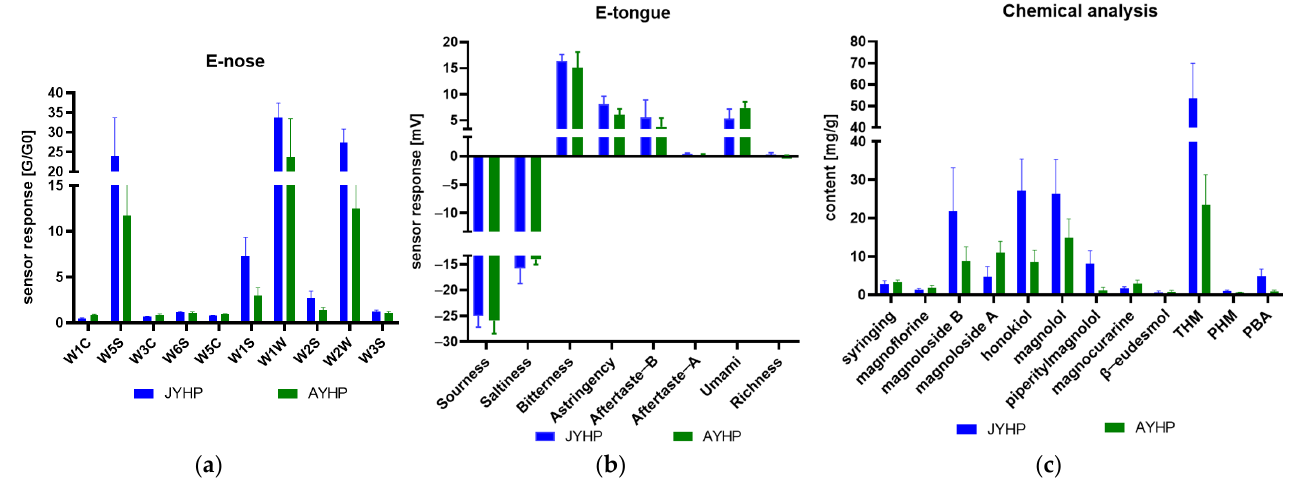
Figure 1. Statistical results of e-nose ( a ), e-tongue ( b ), and chemical analysis ( c ) of the primitive samples from two origins (JYHP and AYHP). G: conductivity of the sensor after contact with the sample gas; G0: conductivity of the sensor after cleaning with standard activated carbon filter gas.